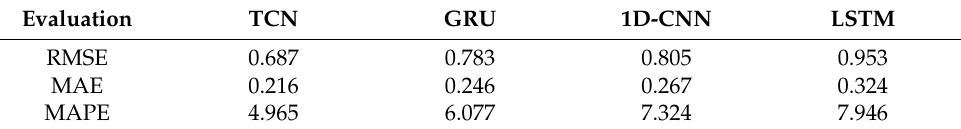
Table 1. Comparison of the forecasting performances of natural gas spot prices on the first working day in the future.